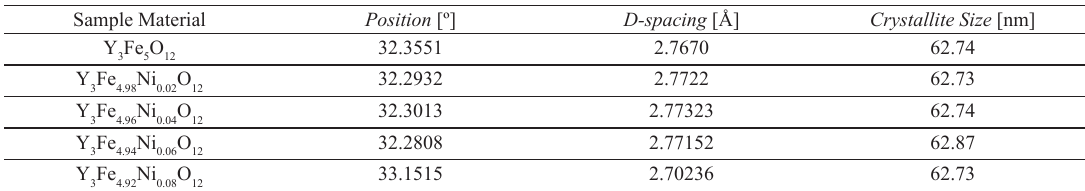
Table 2. Phase Identification results from